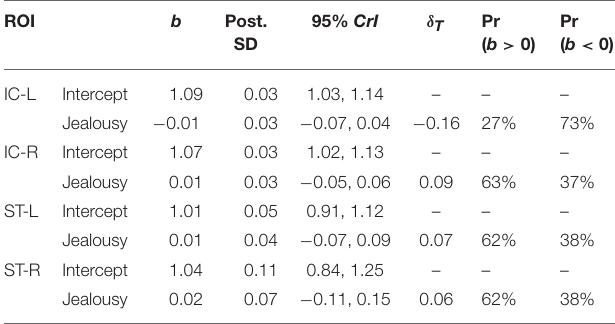
TABLE 4 | Multivariate multilevel model estimates for regions from the rhesus monkey study. ROI b